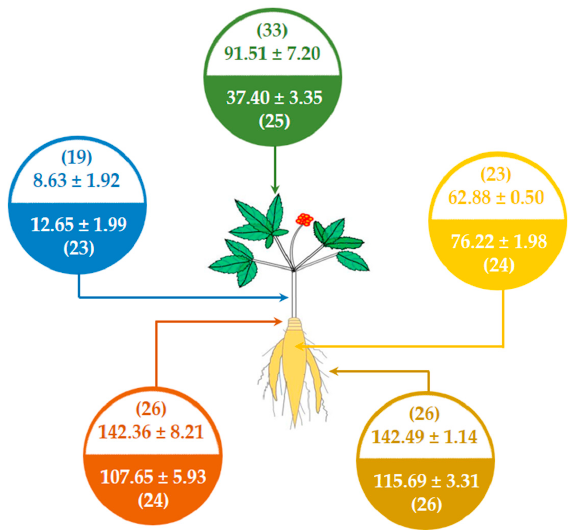
Figure 8. Comparison of ginsenoside components between New Zealand-grown Asian ginseng (colorless background) and New Zealand-grown American ginseng (colored background) in leaf (green), stem (blue), rhizome (red), fine root (brown), and main root (yellow). The numbers in parentheses refer to the number of ginsenosides identified by qualitative analysis, and the other numbers refer to the total content of ginsenosides (mg/g) quantified by quantitative analysis. Supplementary Materials: The following are available online at www.mdpi.com/xxx/s1: Table S1: The regression equations, linear ranges, limits of detection and limits of quantification of 14 ginsenosides.